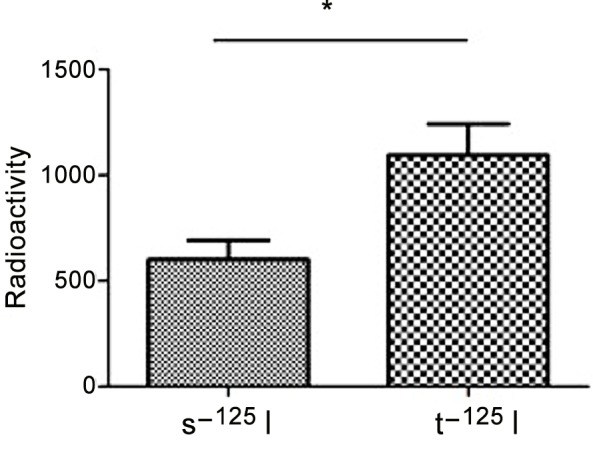
The radioactivity comparison of s-125I seeds and t-125I seeds.The radioactivity of s-125I is higher than t-125I obviously.